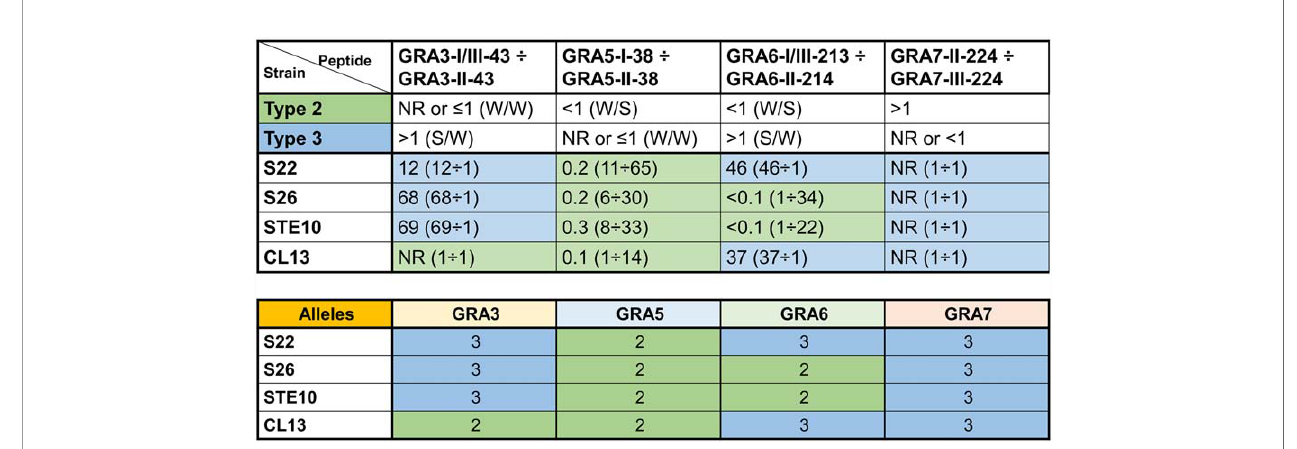
FIGURE 3 | Strains derived from a 2×3 cross can be identi fi ed by seroreactivity against a combination of different GRA peptides. Ratio values of reactivity from strain-speci fi c peptides assayed with serum samples from mice infected with Toxoplasma S22, S26, STE10 and CL13 strains from a 2×3 cross (Sibley et al., 1992). Ratios were calculated by dividing the RIPC values (in parenthesis) of speci fi c peptides with their homologous peptide from the different strain types. Numbers above 1 were rounded to decrease decimals (readers are referred to Supplemental File 3 for the exact values). NR, non-reactive, designates ratios of 1 derived from samples that did not react to any of the two peptides. At the top, the observed behavior of type 2 (M4, ME49 and PRU) and 3 (CEP and CL14) samples are shown as a reference ( Figure 2 ), where the strength (S, strong; W, weak) of each peptide is indicated in parenthesis and separated by a division mark (/). Predictions were made based on this and highlighted in green and blue for type 2 and 3 alleles, respectively. At the bottom, the actual alleles for each strain that can be found at http://toxomap.wustl.edu/IIxIII_Typing_Table.html are